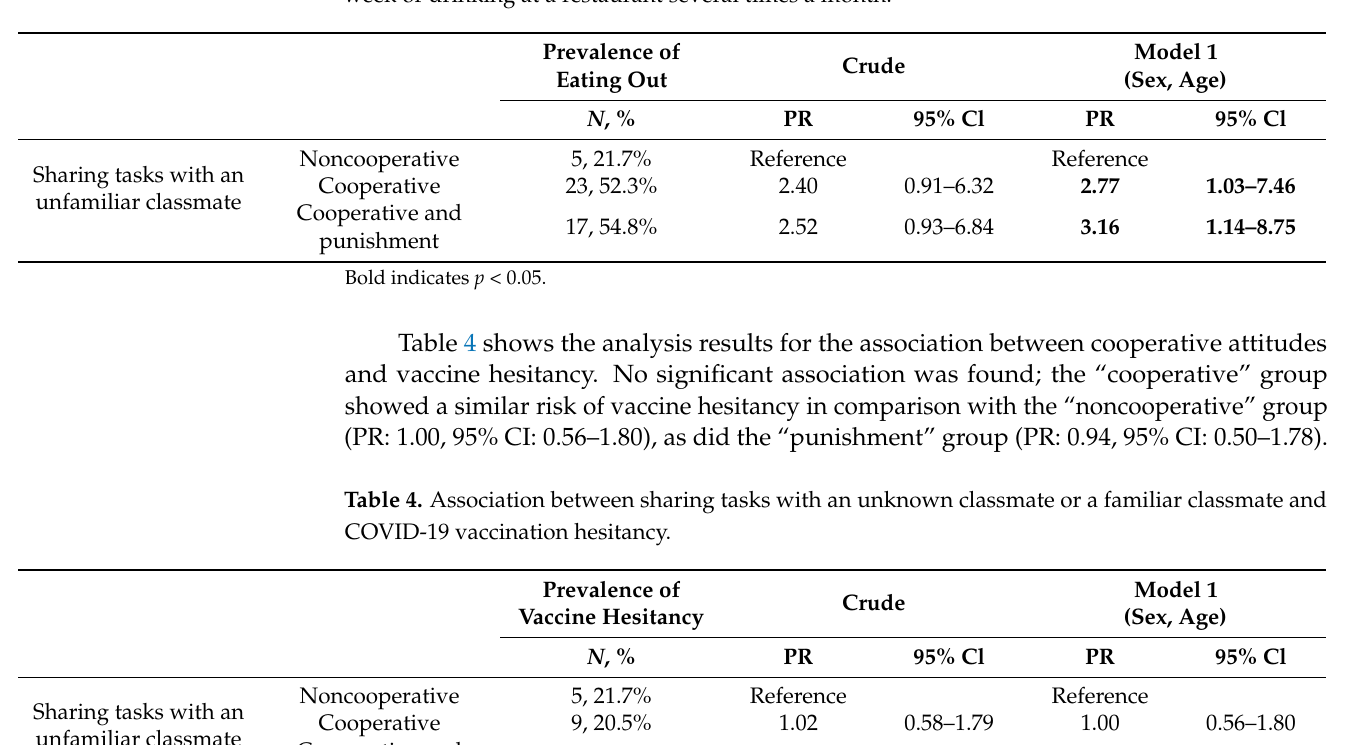
Table 3. Association between sharing tasks with an unknown classmate and eating out at least once a week or drinking at a restaurant several times a month.